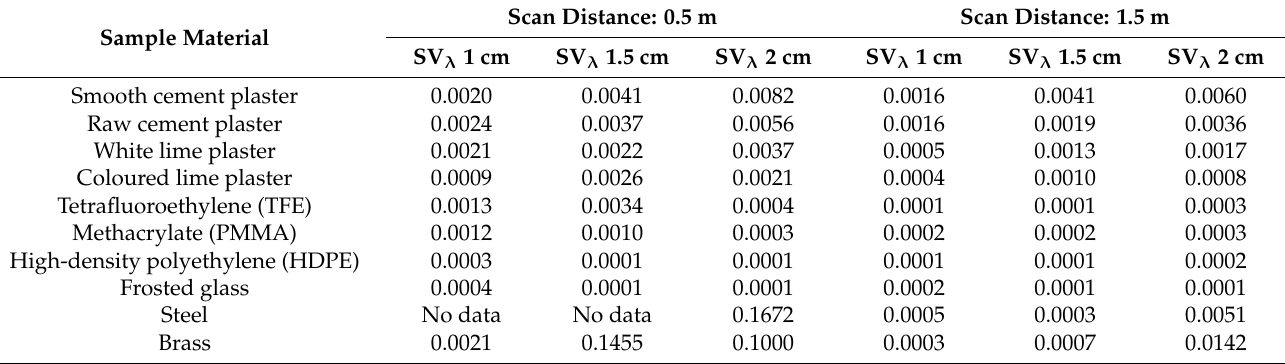
Table A1. Mean surface variation values of the scans of the 10